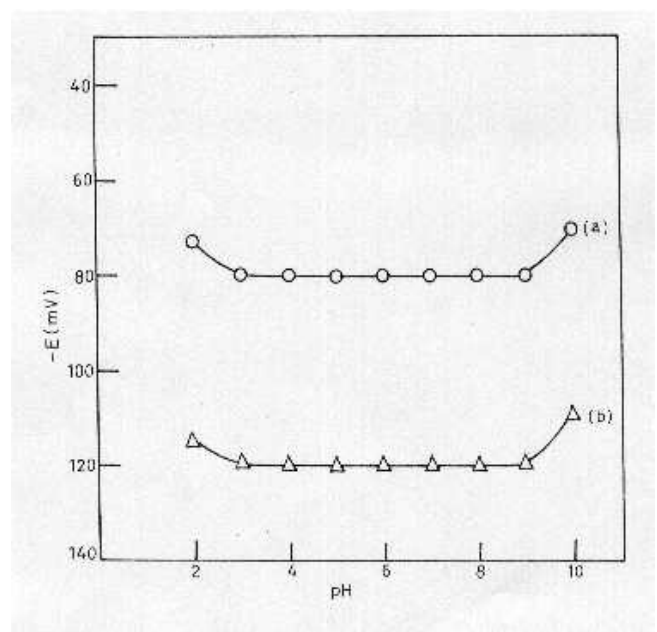
Figure 2. Effect of pH on cell potential; [Ag + ] = 1.0 × 10 -2 M (a) and 1.0 × 10 -3 M (b).